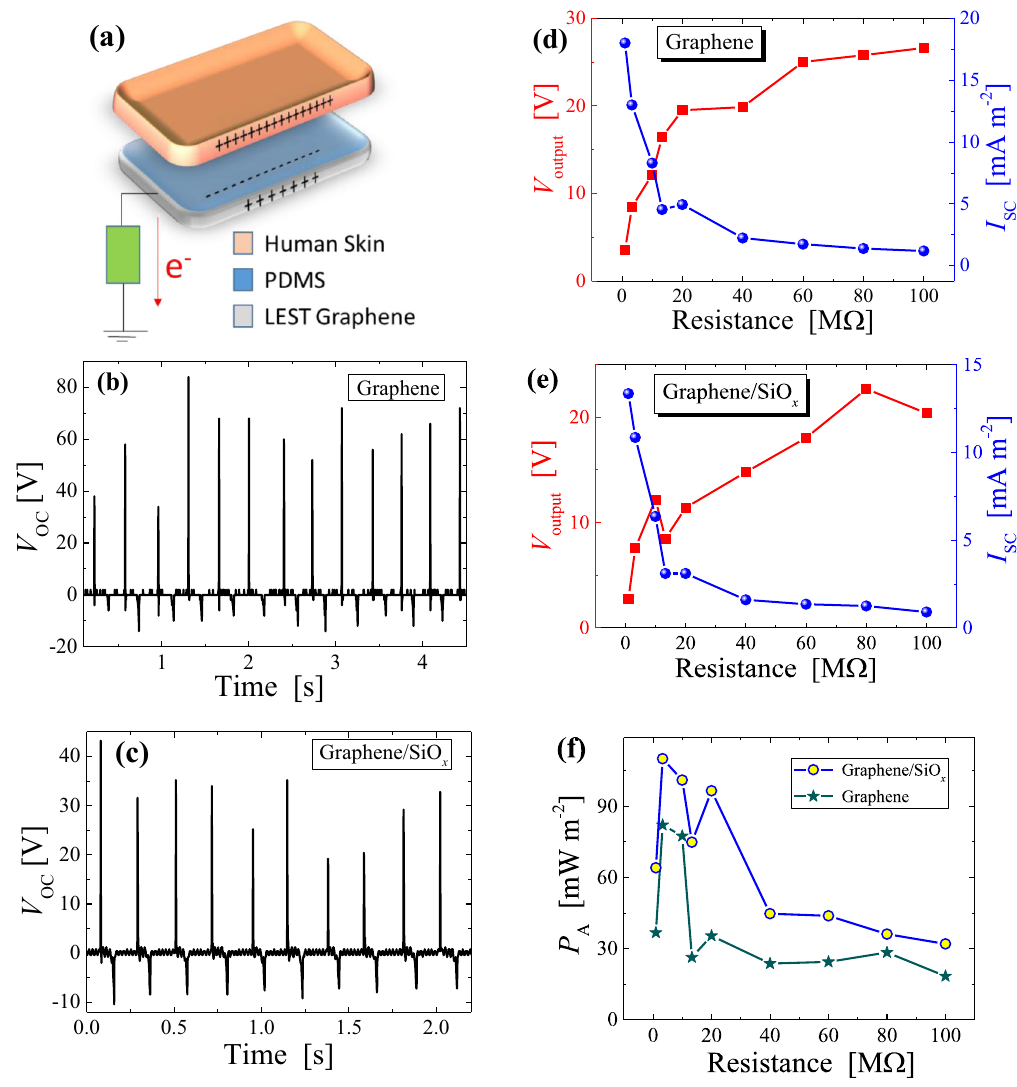
Fig. 6 Performance of TENGs devices. a Schematic of the structure of the single-electrode TENG device. b , c V oc generated during contact and separation of PDMS with human skin with graphene and graphene-SiO x nanohybrid as electrode, respectively. d , e Output voltage and short circuit current ( I SC ) generated upon different external load resistors. f Output power density of the TENG devices as a function of the load Fig. 6d, which in turn provided slightly higher values in the instantaneous output power. A remarkable fi nding of this work is that the external resistance value providing maximum output of the TENG, R L , is among the max lowest reported in the literature. Given the high impedance of other reported TENGs, this is a signi fi cant advantage of the current device, considering that the reduction of the internal impedance is highly desirable in a number of devices requiring low impedance loads for many practical applications 56 . A detailed investigation on the conditions of P A in TENGs has shown that the value of the out decreases proportionally with the frequency of the force R L max applied to the TENG device 56 . This is a very signi fi cant result, as the implementation of high frequency TENG operation in wearable electronics is practically limited in several application to physical constraints. Apparently, the current design emerges as a promising solution towards realizing tactile sensors and other components embedded in electronic textiles. Theoretical modeling of TENG operation has shown that R L max and P A depend upon the fi lm thickness of the tribo-material 56 . out